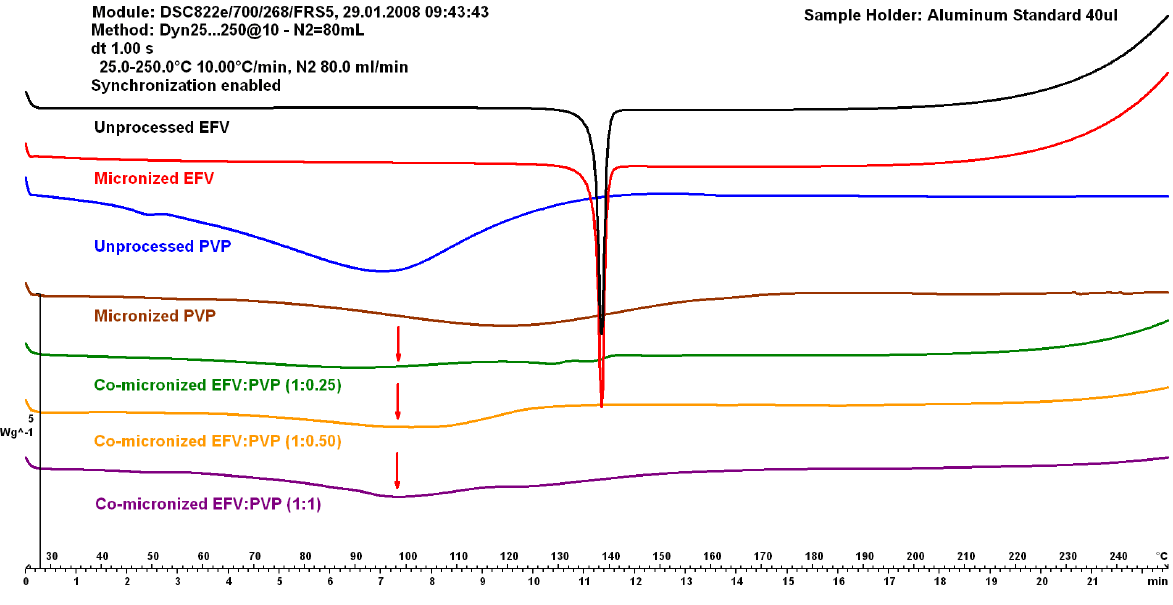
Figure 8. DSC curves of unprocessed and micronized efavirenz and PVP, compared to the co-micronized mixture proportions of (1:0.25), (1:0.50) and